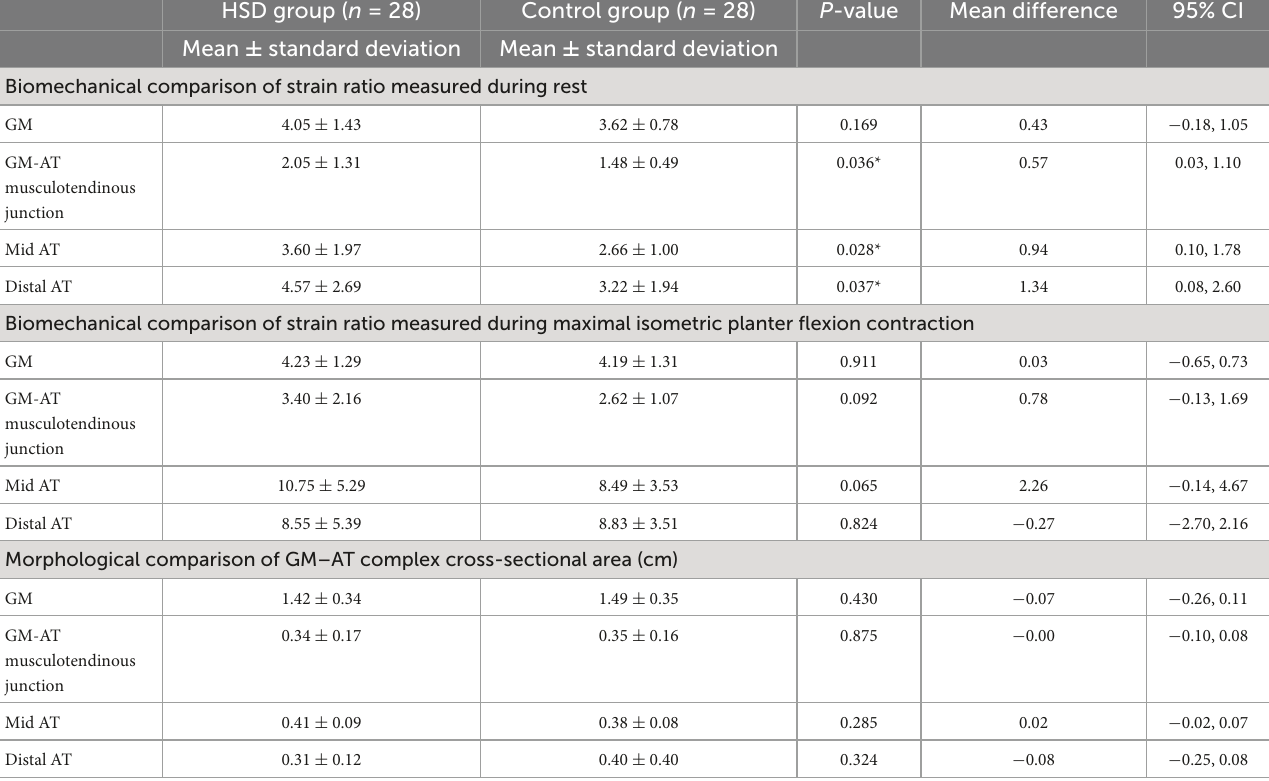
TABLE 2 Biomechanical and morphological comparison between the hypermobility spectrum disorders (HSD) group and the control group measured with compression sonoelastography and B-mode ultrasound, respectively. HSD group ( n = 28) Control group ( n = 28) P -value Mean difference 95% CI Mean ± standard deviation Mean ± standard deviation